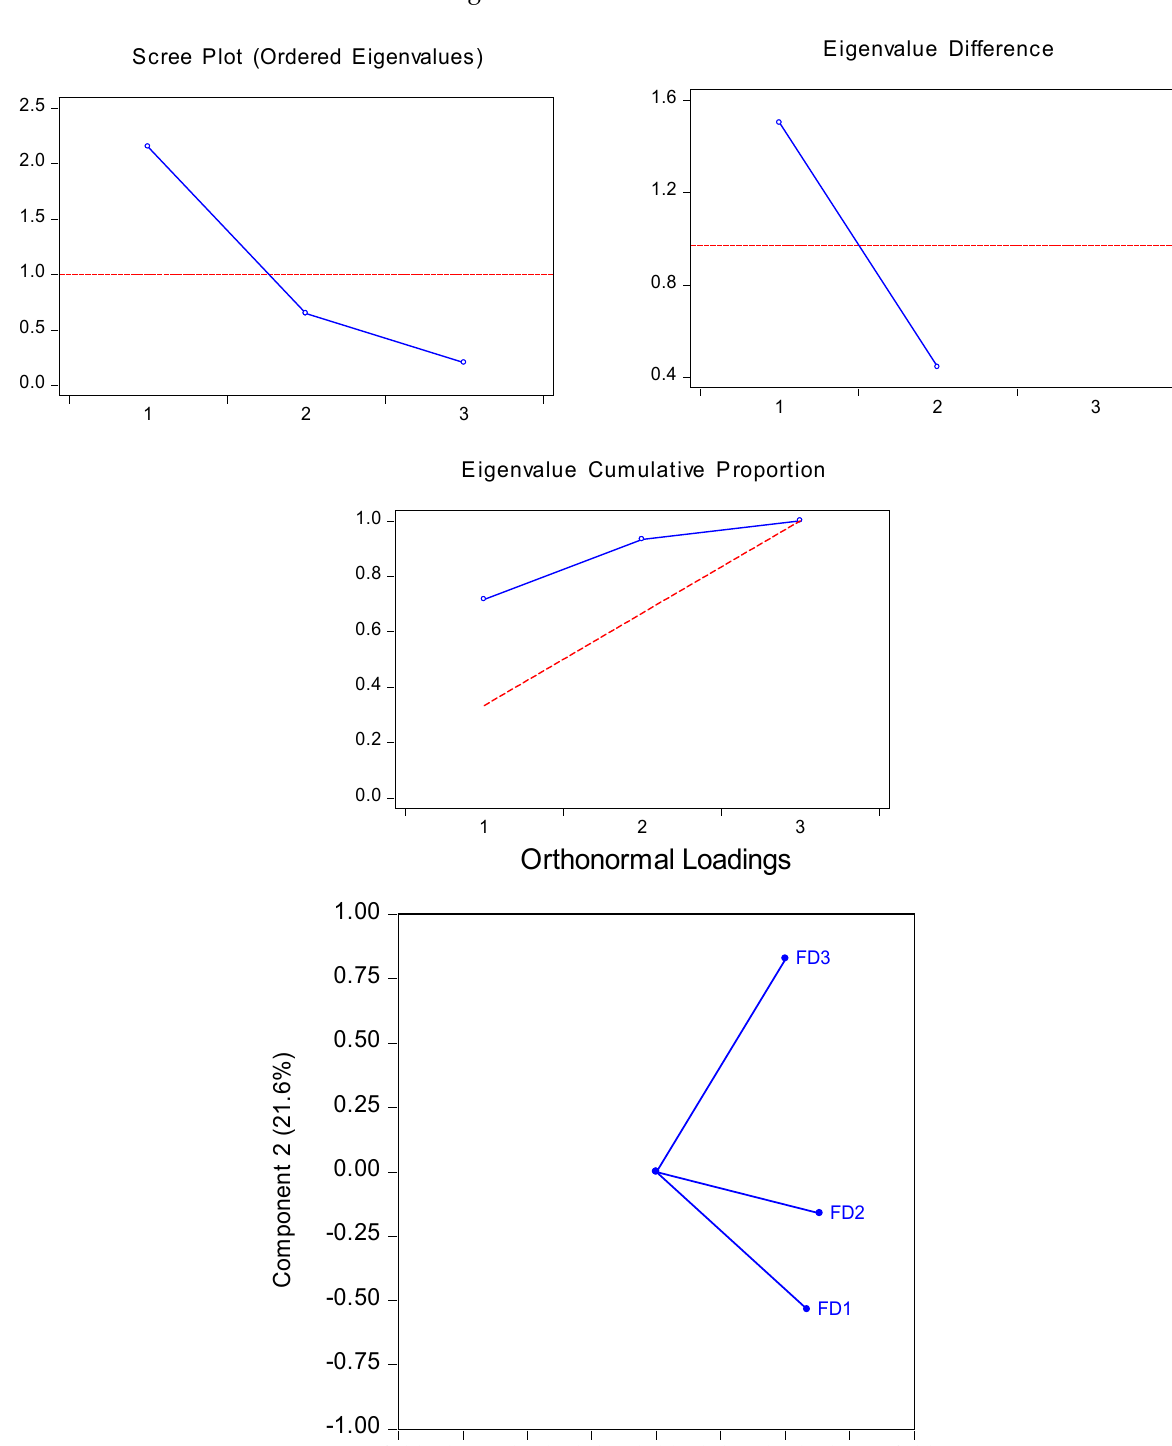
Figure 1. Eigenvalue Plots and Loadings for FDINDEX. Source: Authors’ estimate.